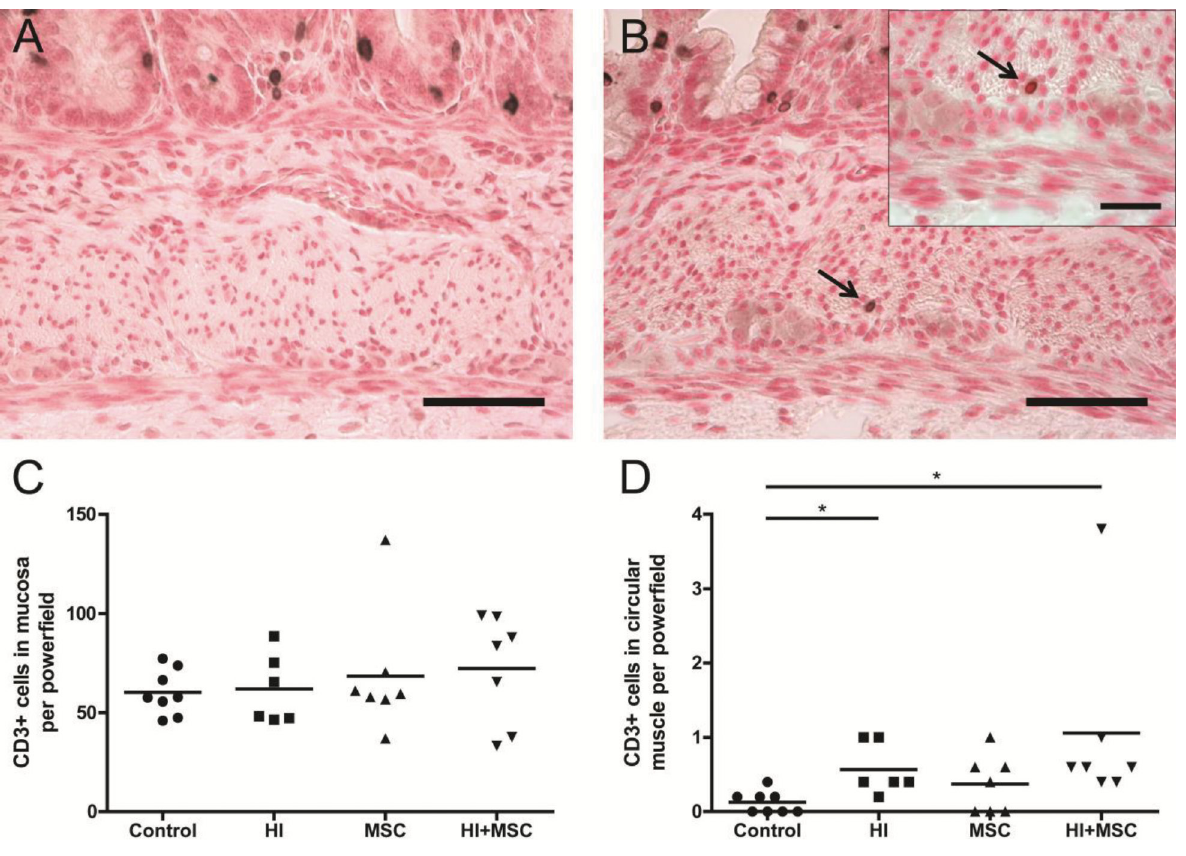
figure 3. Invasion of CD3 + cells in the circular muscle layer 7 d after HI. Representative intestinal sections of (A) control and (B) HI animals were stained by immunohistochemistry for CD3. For each experimental group, CD3 + cells (arrow) in the mucosa (C) and circular muscle layer (D) were counted, and the mean cell counts per power field per animal are given. The scale bar in panels A and B represents 50 μ m. The scale bar in insets represents 20 μ m. * p < 0.05.